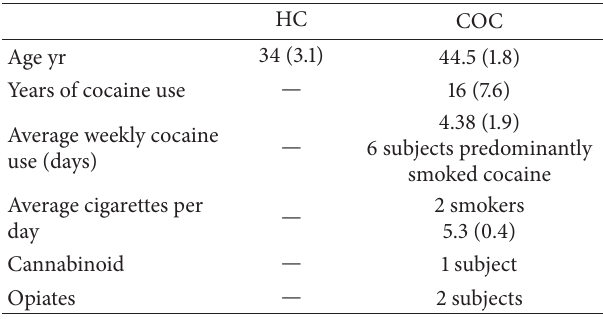
Table 1: The top panel shows demographic characteristics and current drug use data of healthy control (HC), cocaine-dependent (COC) participants. Demographics are presented as average ± standard deviation or number of